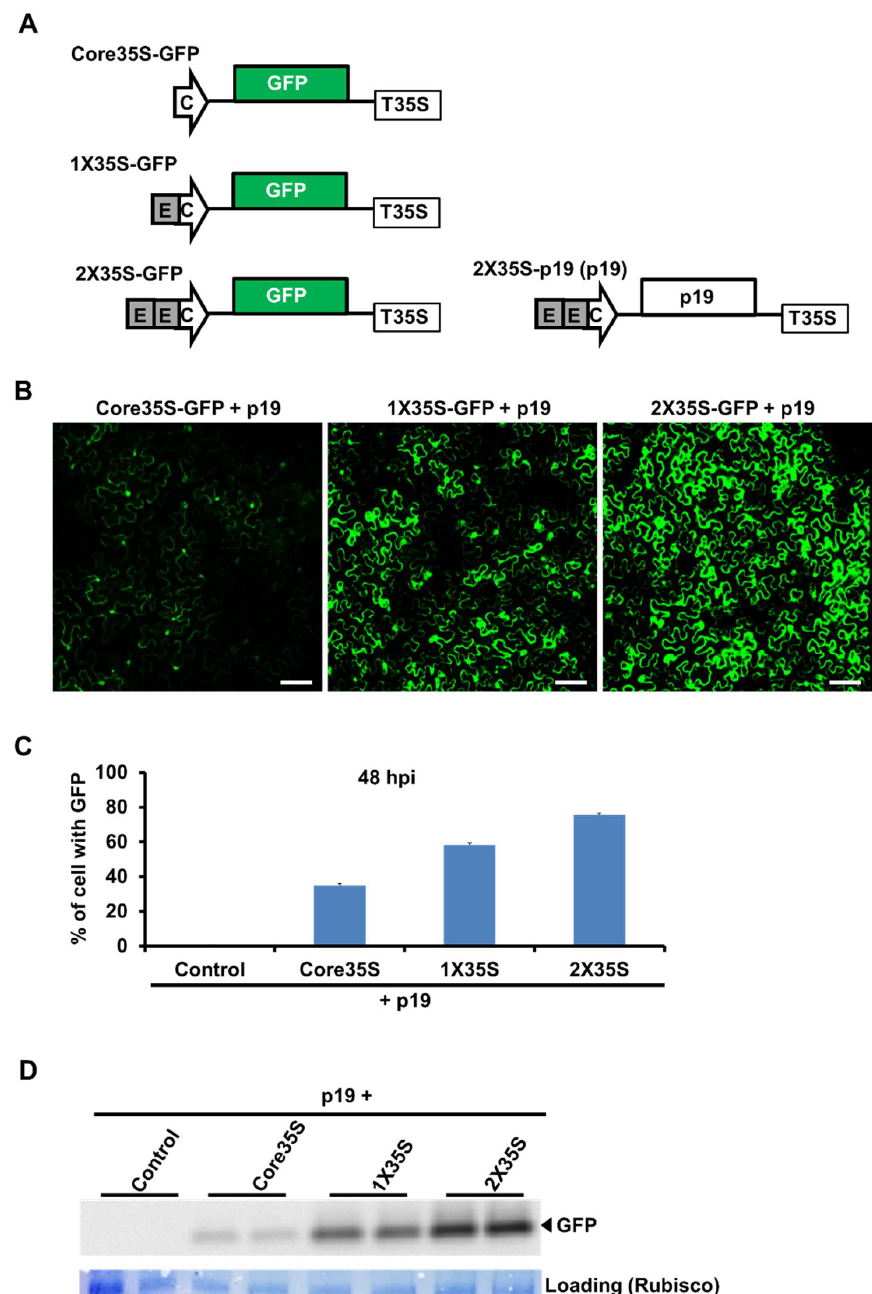
Figure 1. Variation of 35S promoter strengths in N. benthamiana plants determined by GFP expression. ( A ) Schematic representation of the different 35S promoter based GFP constructs. ( B ) Microscopic (confocal microscopy) images of N. benthamiana leaves infiltrated with the different 35S promoter-based GFP constructs with the p19 construct. The size bar = 100 μm. ( C ) Expression (%) of cell with GFP. Five same size pieces of leaves were taken from five different inoculated plants. One appropriate scanning field comprising 45 to 60 cells was chosen. The total % cells with GFP in this field were countered at 48 hpi. ( D ) Western blot analysis to determine the level of GFP expression with a GFP antibody. Coomassie blue-stained Rubisco large subunit ( RbcL ) is shown as a loading control. This experiment was conducted twice with similar results. Here, arrowed-C indicates Core35S promoter, gray-boxed-E indicates enhancer, boxed-p19 indicates a silencing suppressor obtained from tomato bushy stunt virus (TBSV), and boxed-T35S indicates the cauliflower mosaic virus 35S terminator.